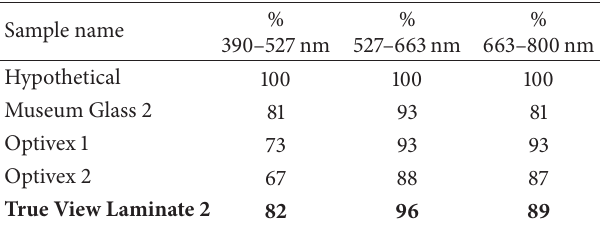
Table 2: The % integrated area transmission for each of the best performing UV blocking samples in three ranges of wavelength within the visible region of the spectrum.